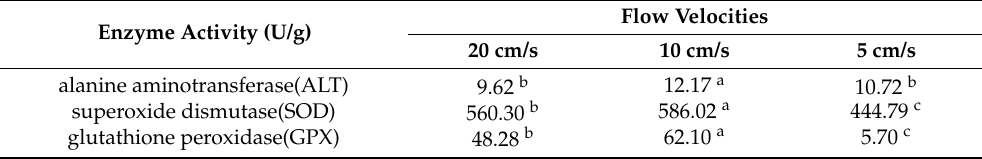
Table 3. Comparison of the liver enzyme activities of P. leopardus under different flow